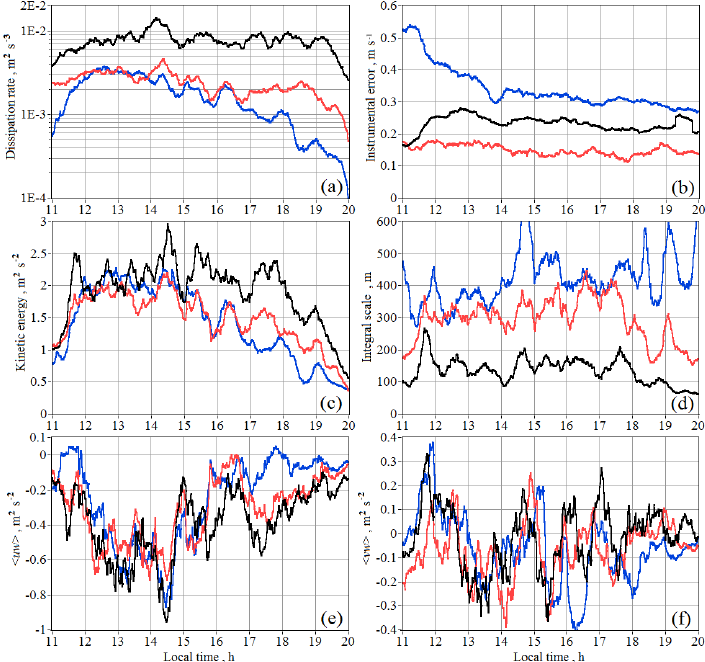
Figure 8. Temporal series of the turbulent energy dissipation rate ε (a) , instrumental error of radial velocity σ e (b) , kinetic energy of turbulence E (c) , integral scale of turbulence L V (d) , and momentum fluxes < uw > (e) and < vw > (f) at heights of 100m (black curves), 300m (red curves), and 500m (blue curves) taken from data of Fig. 7.